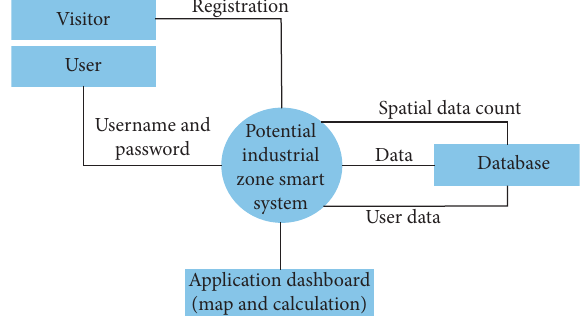
Figure 2: Context